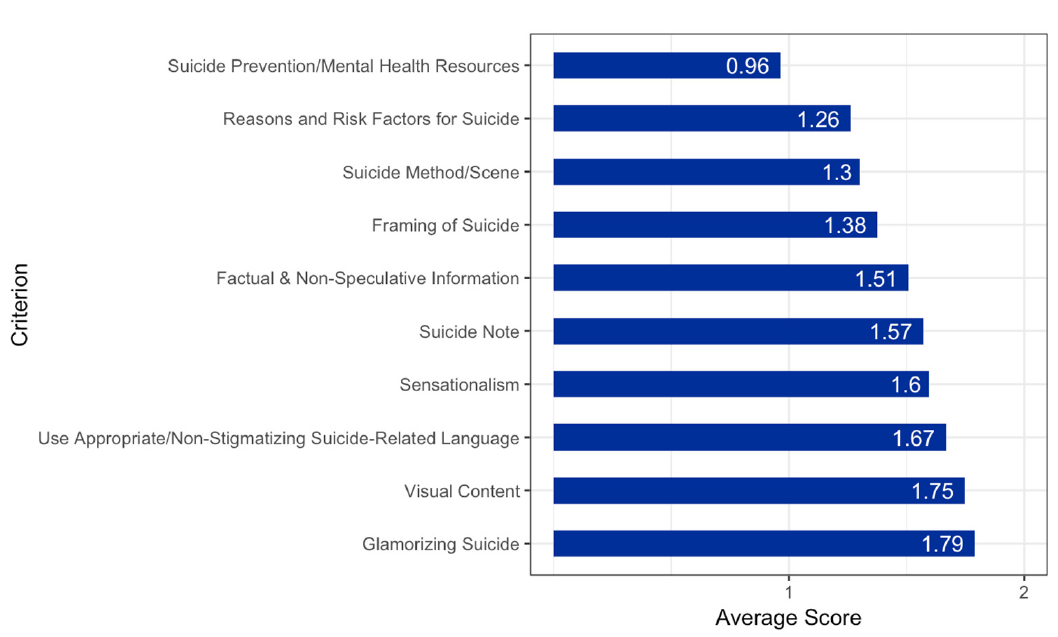
Figure 4. Average Scores for Evaluation Criteria.